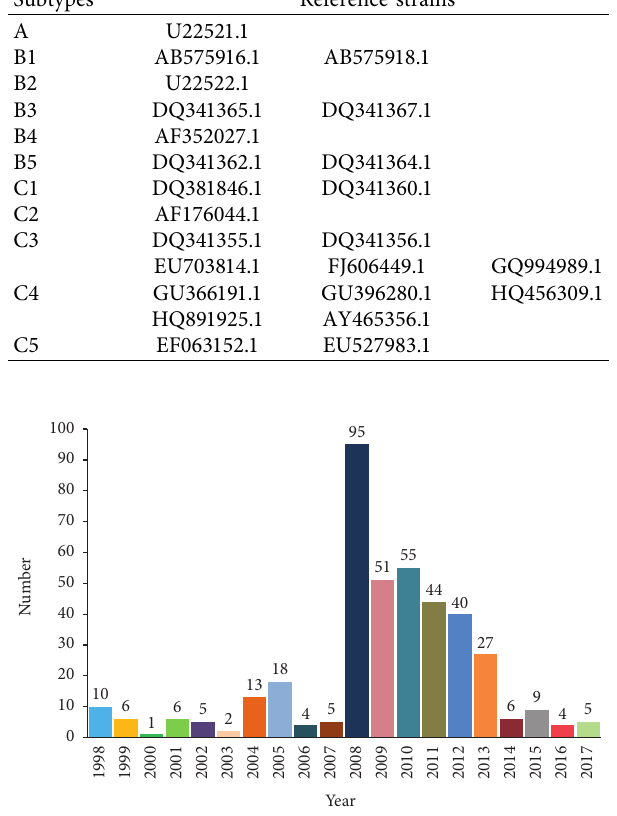
Table 1: Reference strains of EV-A71 subtypes in this study. Subtypes